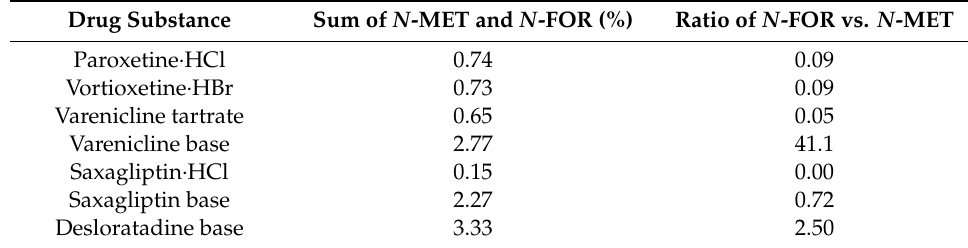
Table 7. Seven model compounds with amine functionality tested for polyethylene glycol (PEG) incompatibility. Two presented parameters were calculated based upon the results of samples of drug substances in combination with PEG and iron oxide (Fe 2 O 3 ) in separate vials after seven days at 60 ◦ C in closed vials (data from Table 6 used).